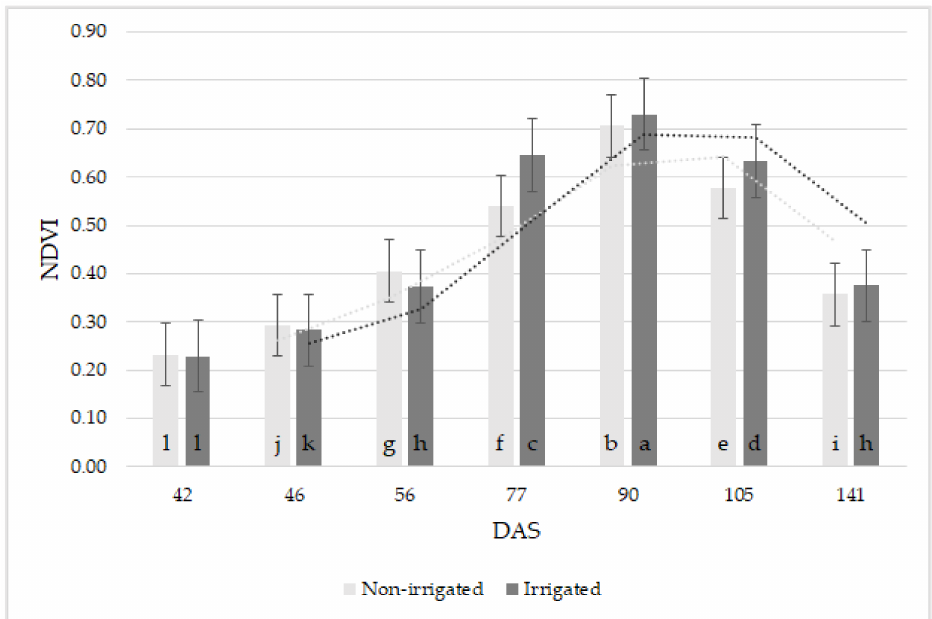
Figure 6. The NDVI UAV values of maize as the effect of irrigation at different DAS (Debrecen, 2021); means of the varieties ± standard error. At the p = 0.001 level, the differences between the DAS treatments were considered significant. The different letters indicate treatments that differ significantly ( p < 0.05). LSD =